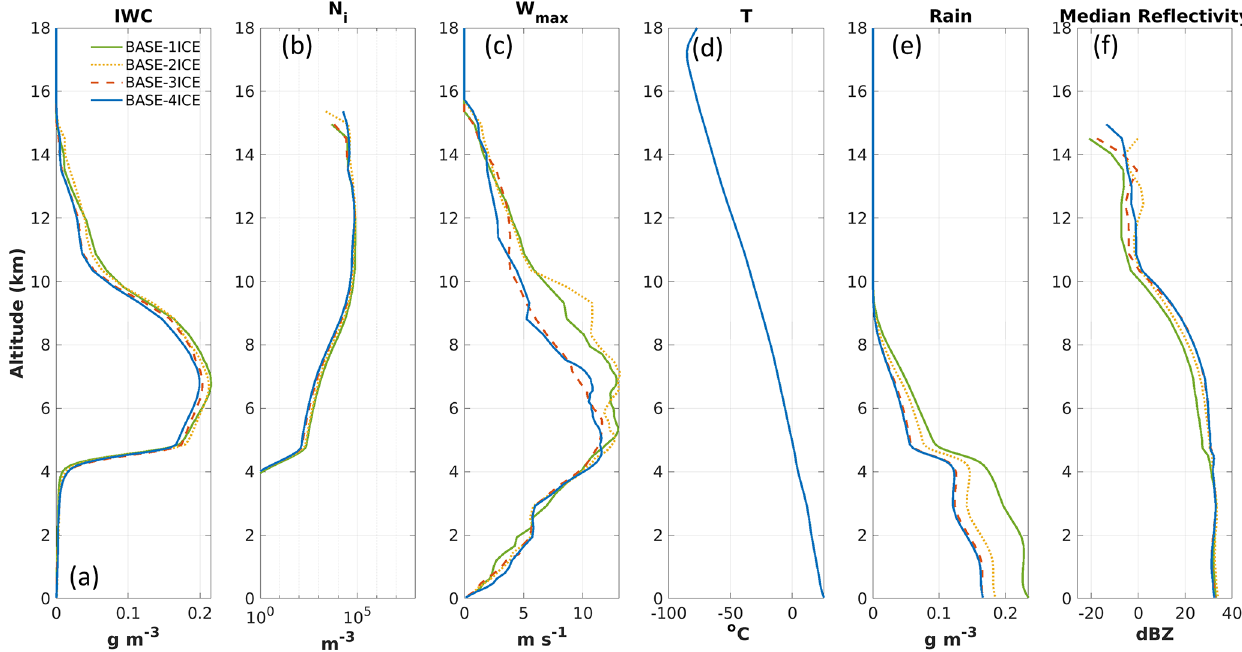
Figure 4. Profiles from the baseline simulations without SIP for (a) ice water content (IWC), (b) ice number concentration ( N i ), (c) maximum vertical wind speed ( W max ), (d) air temperature ( T ; the four simulations have only slightly different temperature that is not distinguishable in the figure), (e) rain water content (RWC), and (f) median radar reflectivity. The profiles are calculated based on data from 90 to 150min of simulation. Panels (a) and (b) are horizontally averaged over regions with IWC > 0.001gm − 3 , panel (c) is the horizontal maximum across the domain, panel (d) is a horizontal average over the whole domain, panel (e) is an average over the area with both ice water path and rain water path larger than 1gm − 2 , and panel (f) shows median values of reflectivity including points with either IWC or RWC larger than 0.01gm − 3 within the mask used for panel (e) .